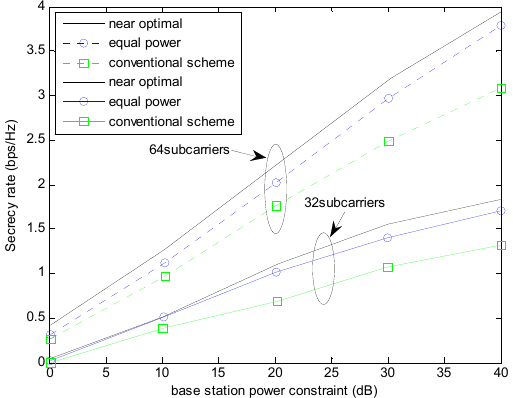
Figure 2. Secrecy spectral efficiency versus base station transmitting power.